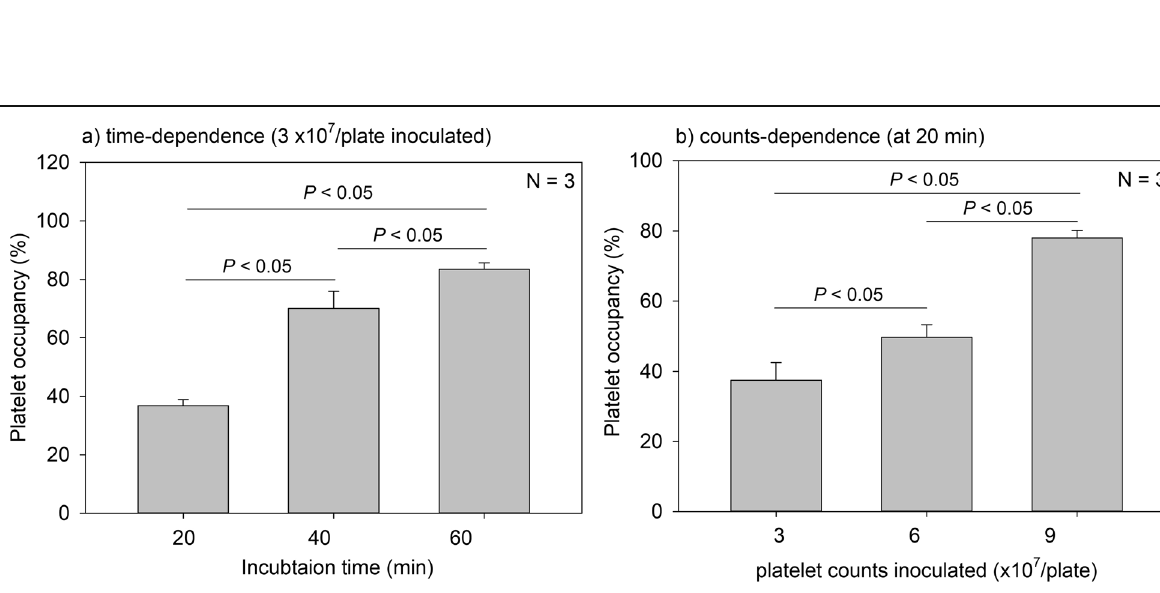
Fig. 6 Time- and count-dependent platelet occupancy on CaP-blasted cp-Ti plates. The images obtained by actin staining were subjected to image analysis and platelet occupancy against the fixed region of interest was calculated. N =